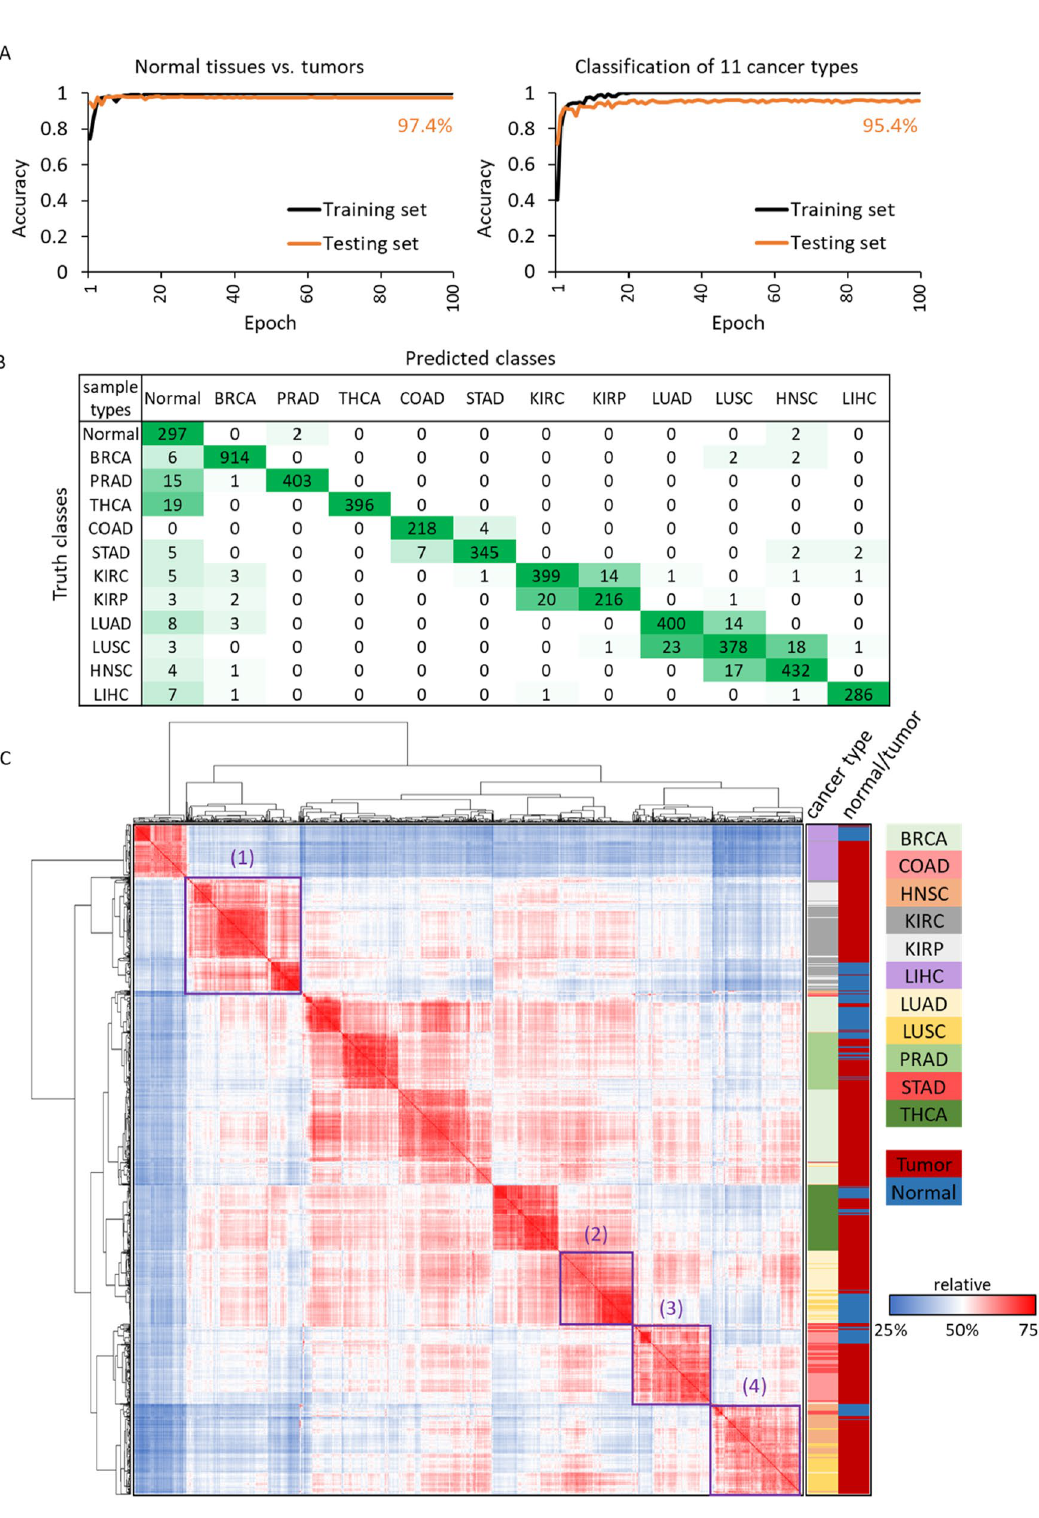
Figure 4. The prediction results of tumors/normal samples and confusion matrix for 11 cancers. The prediction accuracies of ( A ) normal tissues and tumors (left), as well as normal tissues and 11 cancer types (right). The x-axis is 100 training/testing times (epochs); and the y-axis presents accuracy of training/testing. ( B ) The confusion matrix is generated from 4908 independent images. The y-axis is true classes (ground truth) of validation samples and x-axis is prediction classes of CNN model. The diagonal cells are the sample counts of correct prediction/classification. ( C ) The hierarchical clustering of 1228 samples by using Pearson’s r of gene